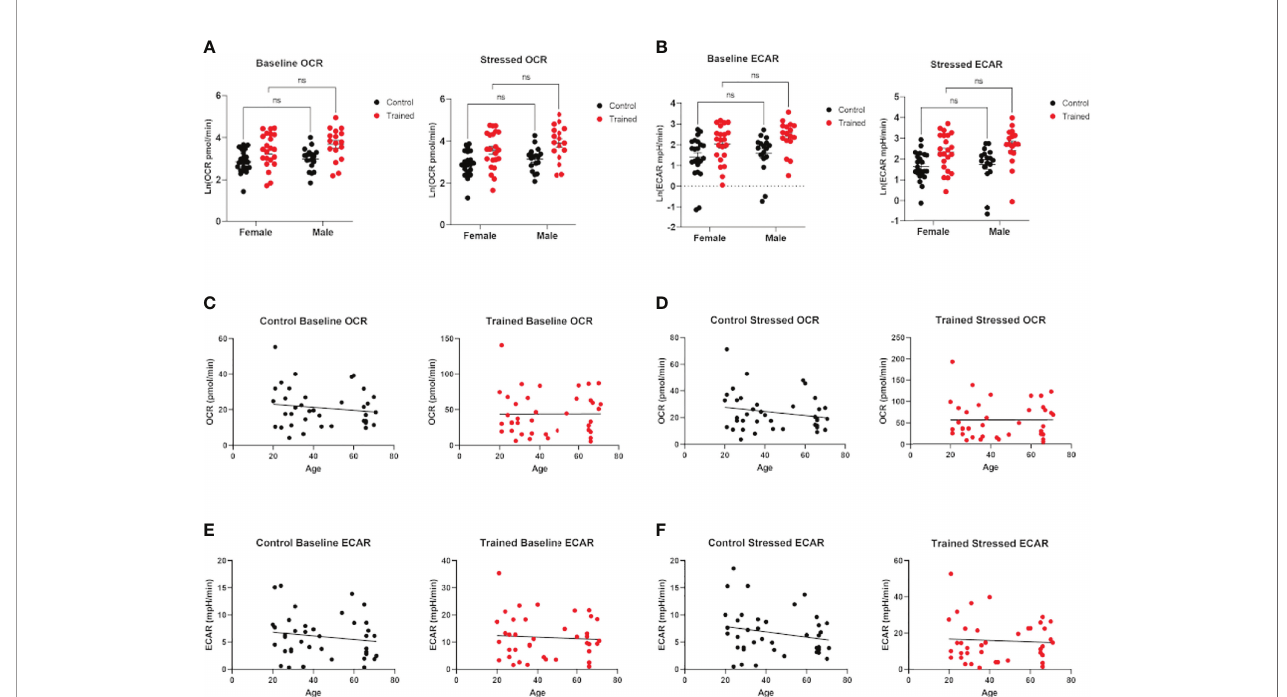
FIGURE 2 | Effect of age and gender on monocyte metabolism in the presence and absence of b – glucan induced immune training. (A) Scatter plot of baseline and stressed oxygen consumption rate (OCR) 7 days after b – glucan or PBS treatment (Female: N=22, Male: N=17). (B) Baseline extracellular acidi fi cation rate (ECAR) and stressed ECAR 7 days after b – glucan or PBS treatment (Female: N=22, Male: N=17). (C – F) Simple linear regression of baseline and stressed OCR and ECAR. No correlations are signi fi cant (N=13). (A, B) were analyzed PERMANOVA for sex and training. ns, not signi fi